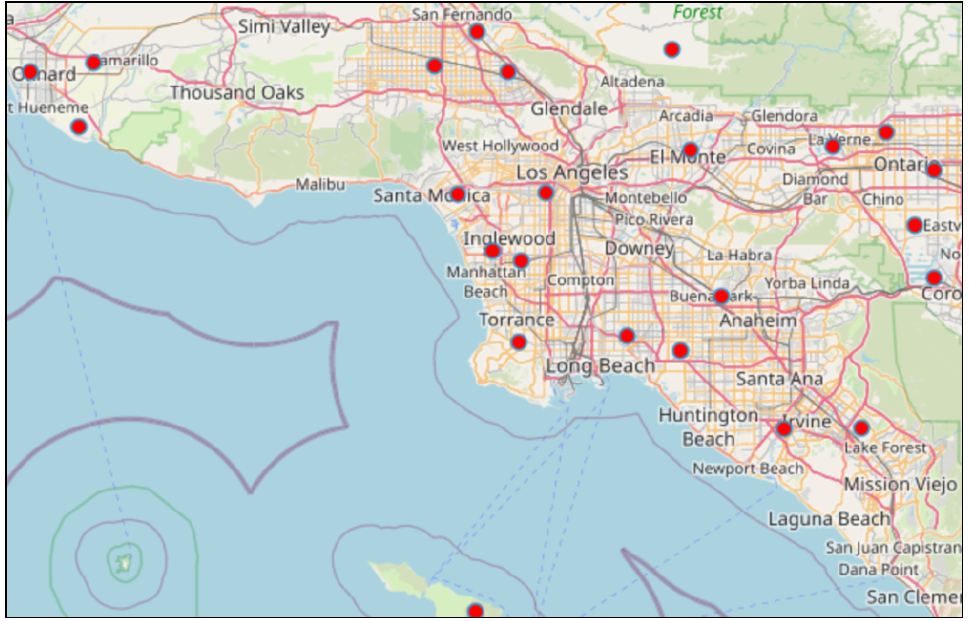
Figure 4. METAR ASOS data from the Mesonet database: 24 sensor locations in Los Angeles county, where each sensor records 17 hourly meteorological